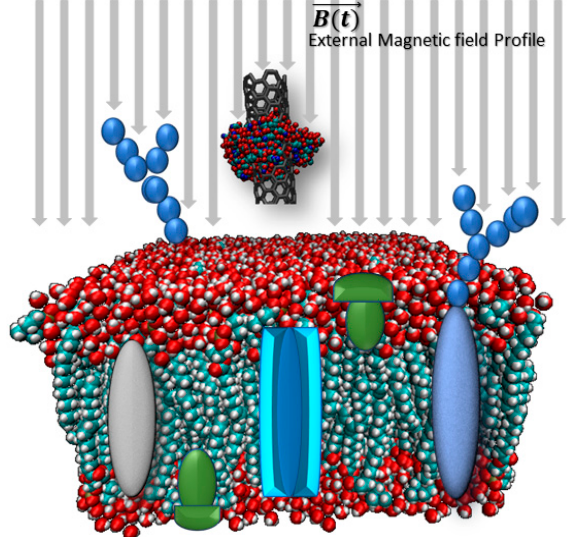
Figure 1. CNTs cross through membrane structure. Functionalized CNTs with drugs and magnetic nanoparticles (MNPs) are guided with a magnetic field to cross through the cell membrane. By applying a predefined external magnetic field profile on the MNPs, the exerted force leads CNTs across the membrane.